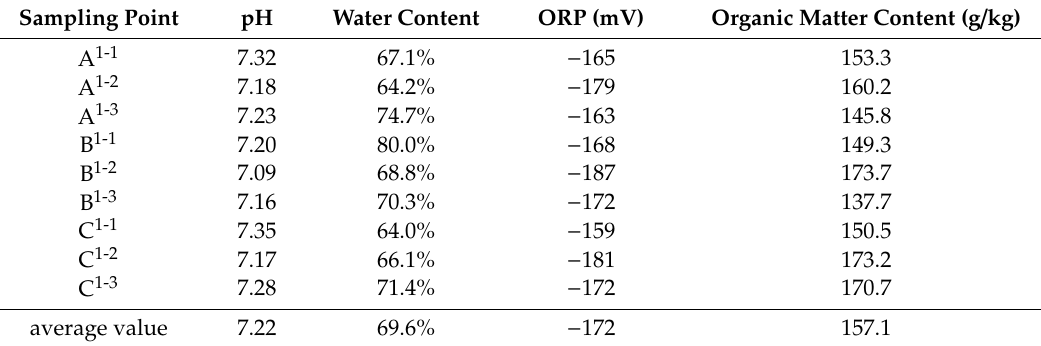
Table 2. The physical-chemical properties of the sediment from the Buji River. ORP: oxidation-reduction